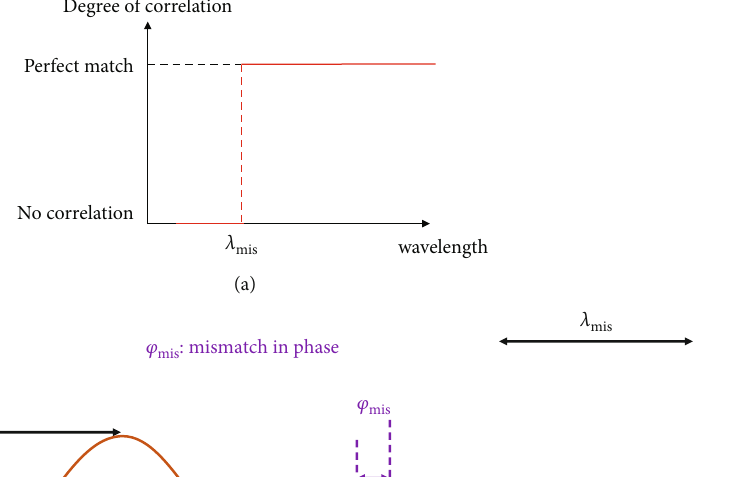
. (b) Example of mis < λ , and the phases of the two 2 mis